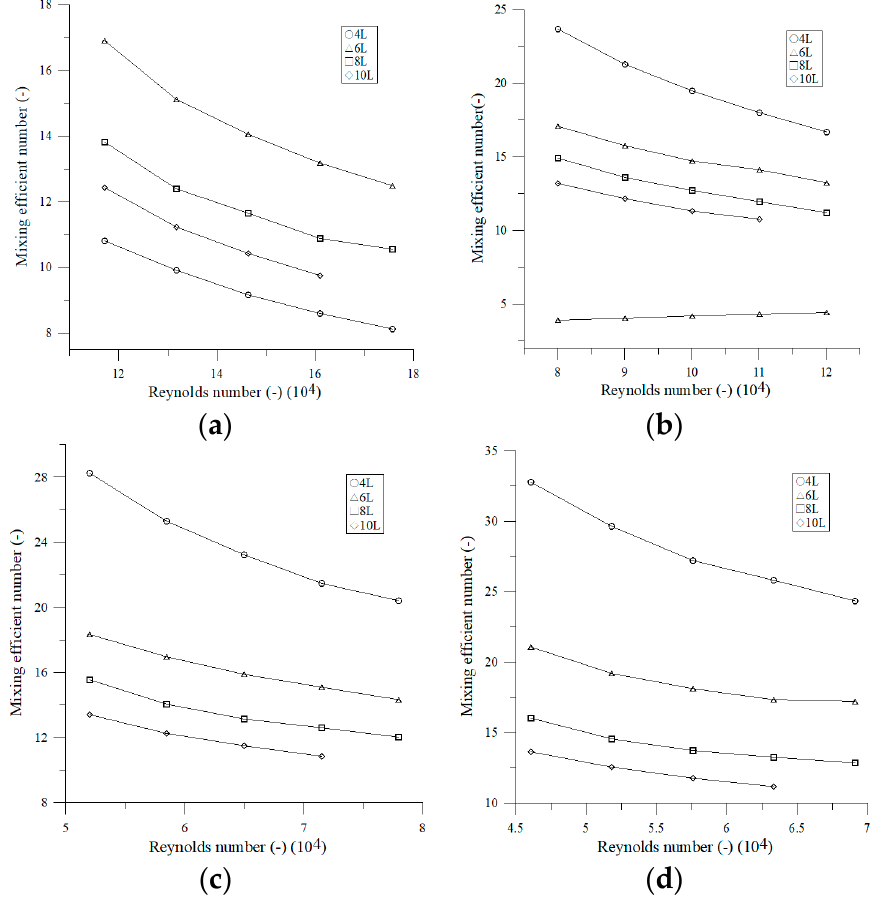
Figure 11. E ff ect of Reynolds number on mixing e ffi cient number. ( a ) Water; ( b ) 5 vol% glycerin; Figure 11. Effect of Reynolds number on mixing efficient number. ( a ) Water; ( b ) 5 vol% glycerin; ( c ) ( c ) 10 vol% glycerin; ( d ) 20 vol% 10 vol% glycerin; ( d ) 20 vol% glycerin.